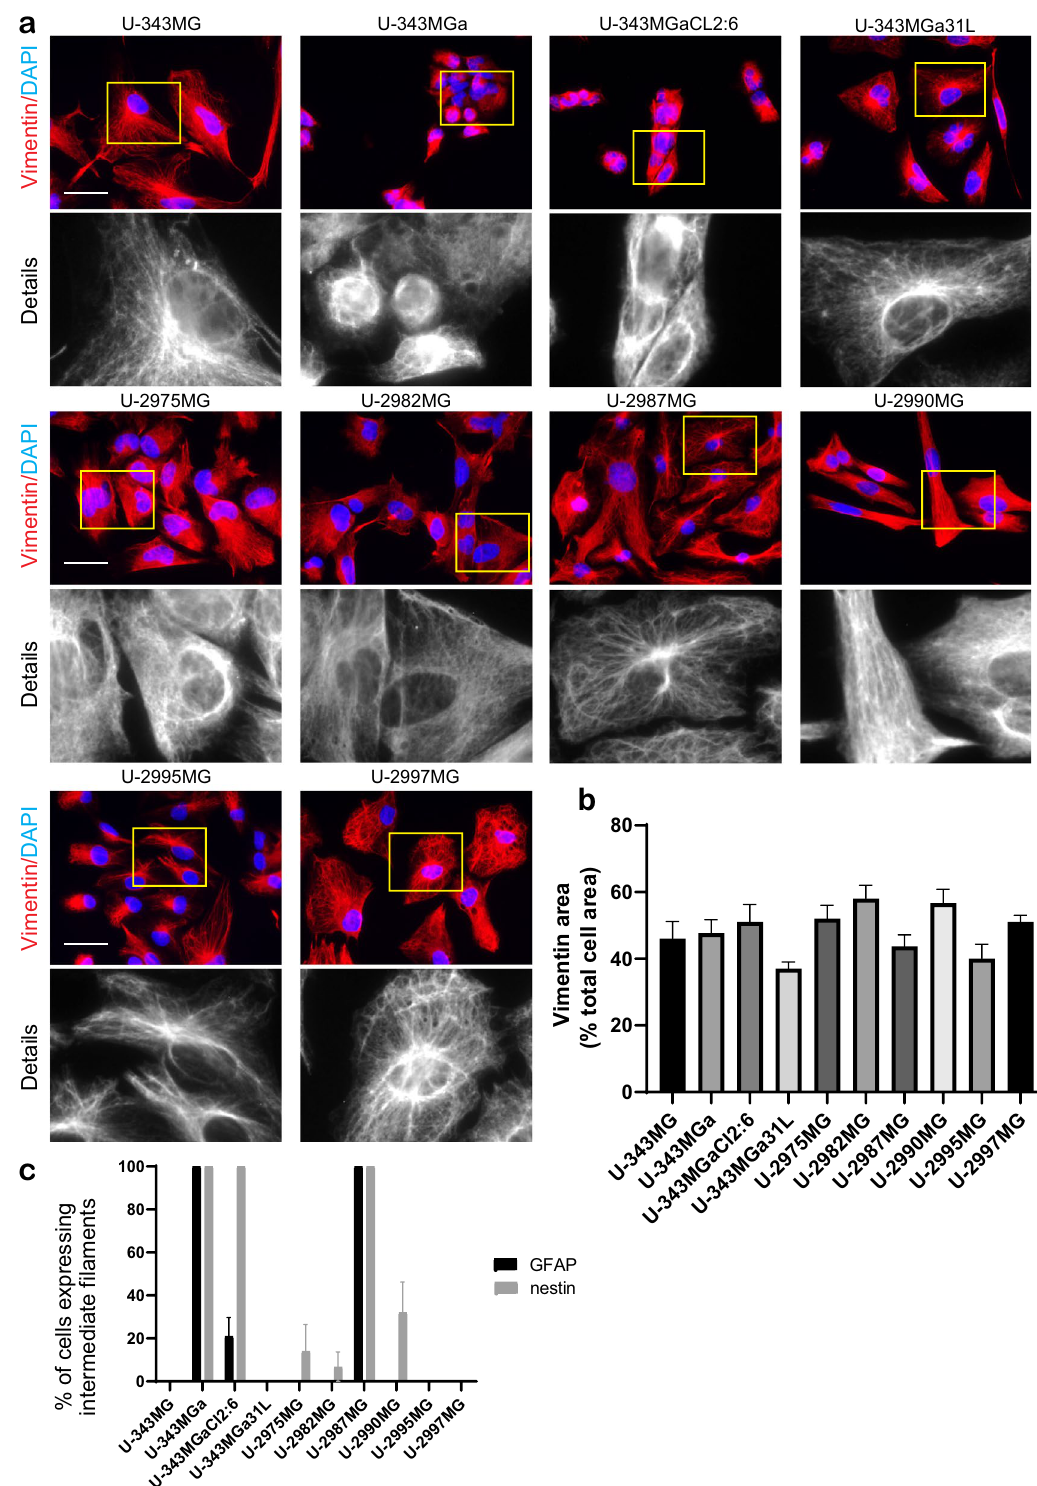
Figure 2. Intermediate filament organization and expression. ( a ) Representative images of vimentin organization, as stained with mouse anti-vimentin antibodies and AlexaFluor568-conjugated anti-mouse antibodies. Scale bar, 50 µm. ( b ) Quantification of the proportions (%) of the areas of the cell occupied by vimentin. Quantification was performed from three independent experiments using ImageJ. Statistical significance was calculated with ANOVA-Tukey’s post-hoc tests and summarized in Supplementary Table S3. ( c ) Quantification of the proportion (%) of cells expressing GFAP and nestin. Quantification was performed from three independent experiments per cell line. Statistical significance was calculated with ANOVA-Tukey’s post- hoc tests and summarized in Supplementary Table